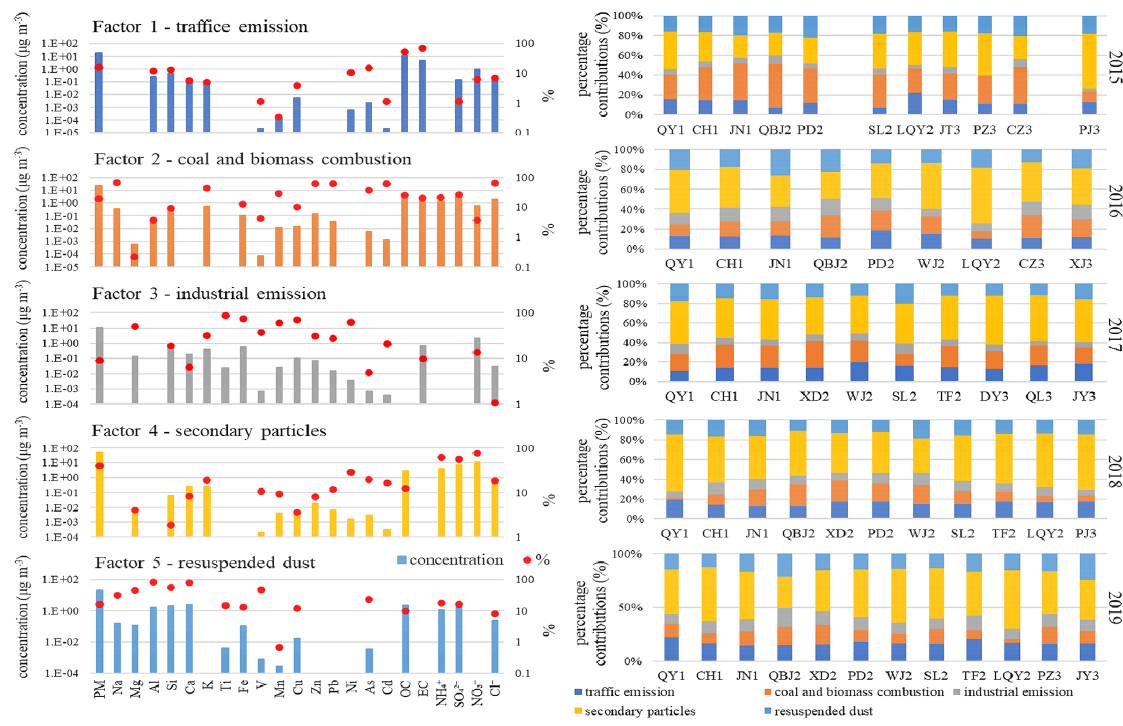
Figure 6. Source profiles estimated by the PMF, in the form of species concentrations (µgm − 3 ) and percentages of species sum (%).